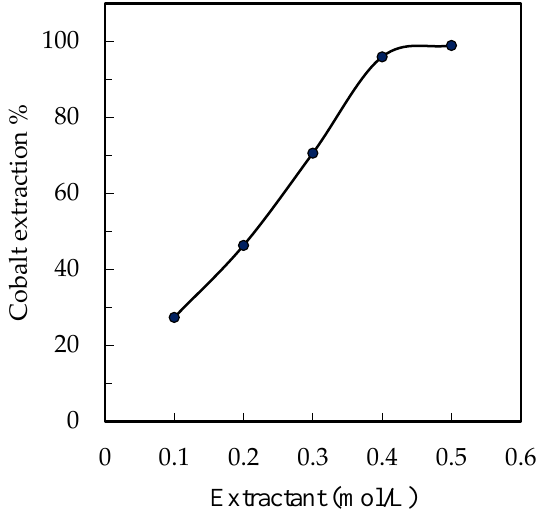
Figure 8. Effect of extractant concentration: extraction at A/O = 1, Xi = 11 g/L, pH = 6, time = 12 min, and temperature = 22 ± 1 °C.